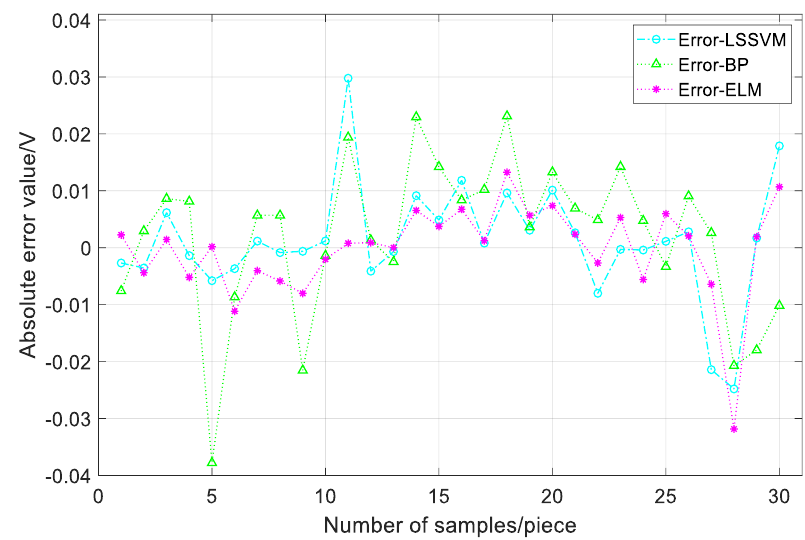
Figure 8. Prediction error for cell voltage with different models.